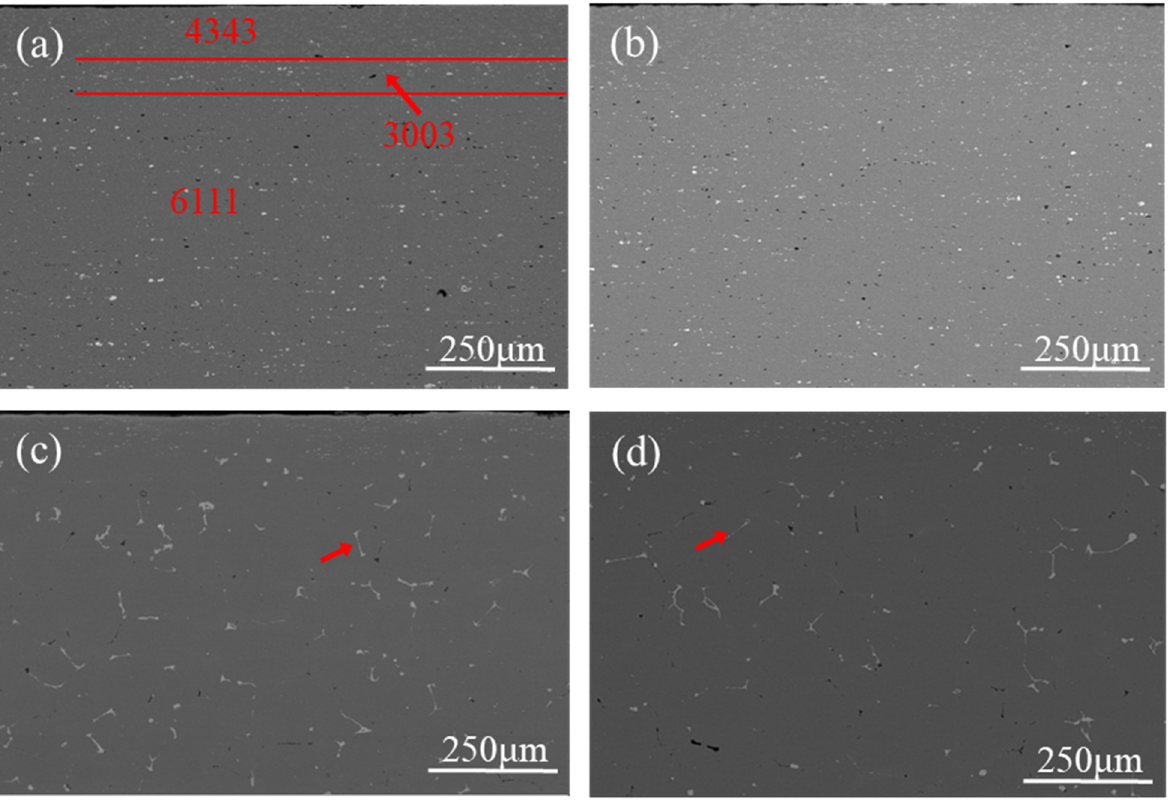
Figure 7. Microstructures of 4343/3003/6111/3003 Al clad sheet under various conditions: ( a ) cold-rolled state; ( b ) 330 °C/3 h (annealed state); ( c ) 330 °C/3 h + 610 °C/10 min (brazed state); ( d ) ( a ) cold-rolled state; ( b ) 330 ◦ C/3 h (annealed state); ( c ) 330 ◦ C/3 h + 610 ◦ C/10 min (brazed 330 °C/3 h + 610 °C/10 min + 180 °C/8 h (aged state). state); ( d ) 330 ◦ C/3 h + 610 ◦ C/10 min + 180 ◦ C/8 h (aged